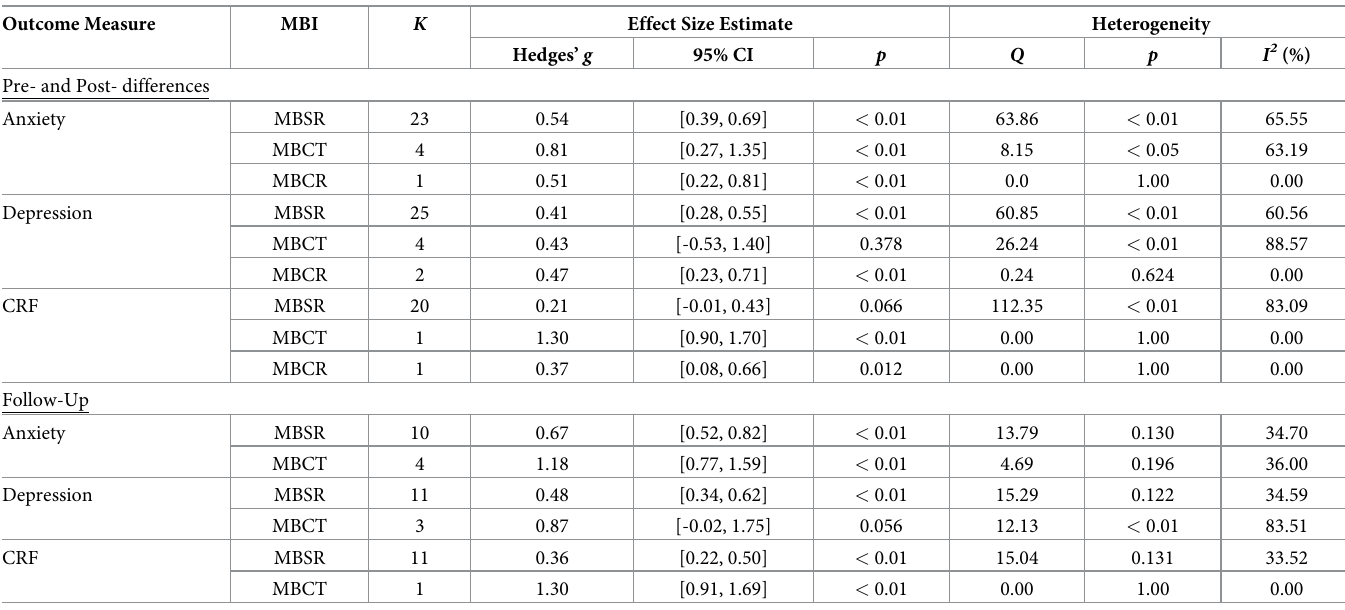
Table 3. Summary of the overall subgroup analyses for within group effect